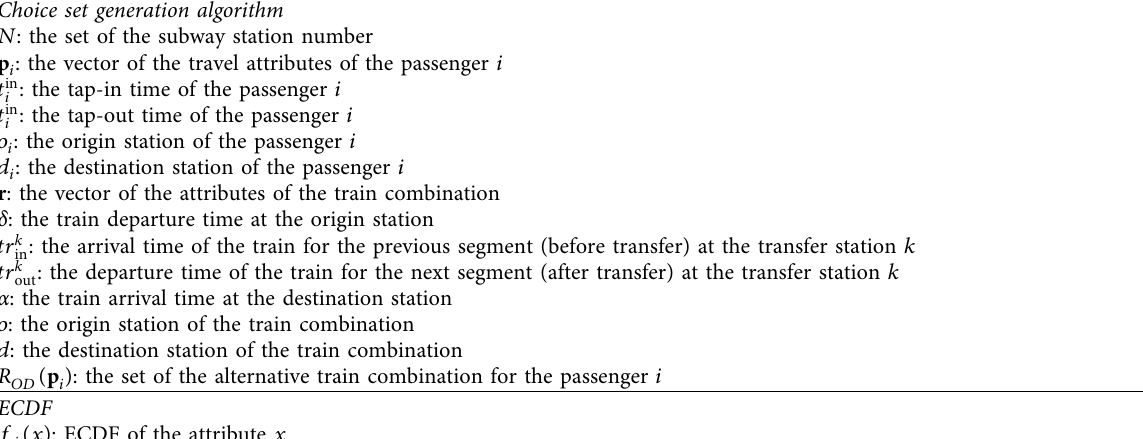
Table 3: Definition of